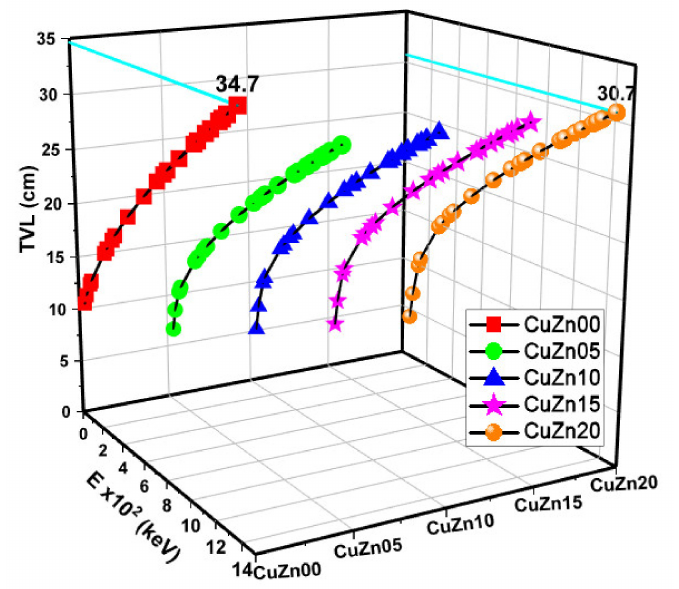
Figure 8. Tenth value layer (TVL) values as a function of photon energy and Cu-Zn content of samples.